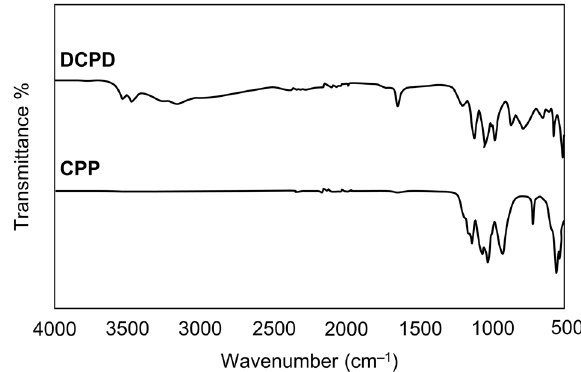
Fig. 1 FTIR spectra of DCPD and CPP seed